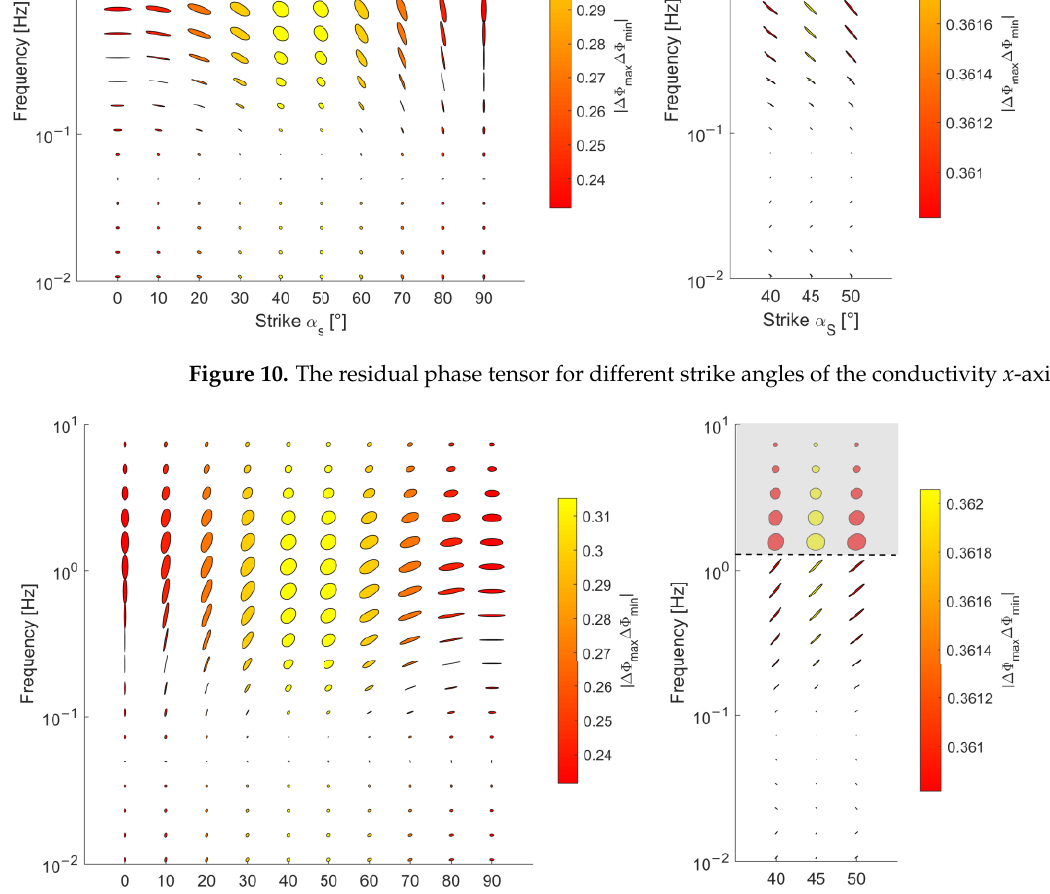
Figure 11. The residual phase tensor for different strike angles of the conductivity y-axis.